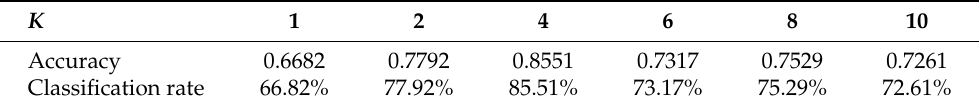
Table 3. The KNN prediction accuracy for real